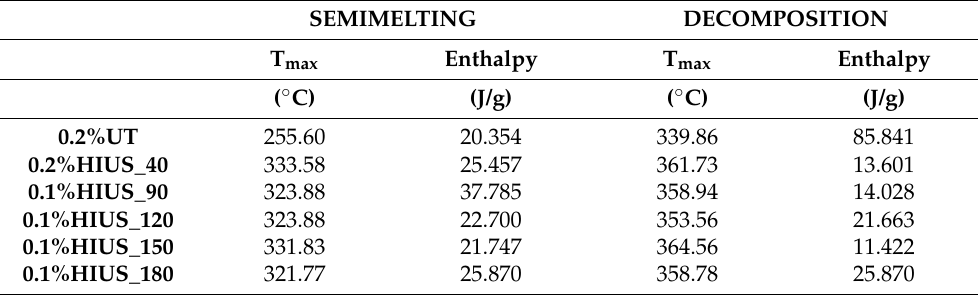
Figure 4. DSC curves of the studied cellulose after HIUS treatment. Table 3. The crystallinity index and thickness of crystallites of cellulose isolated from hop stems after different duration of HIUS treatment.